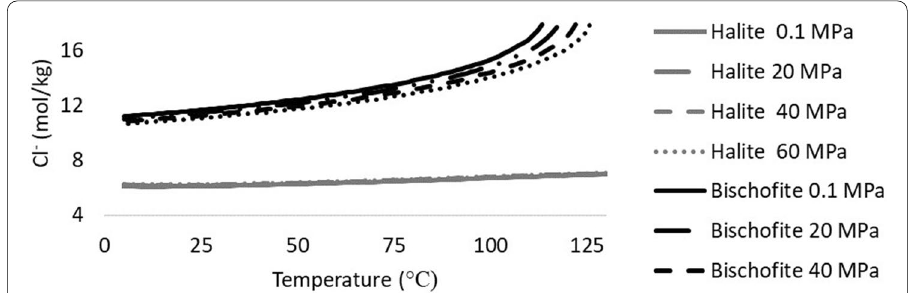
Fig. 2 Cl − concentration in solution for halite and bischofite solutions in freshwater with changes in temperature and pressure from the Pitzer.dat from Moore and Holländer